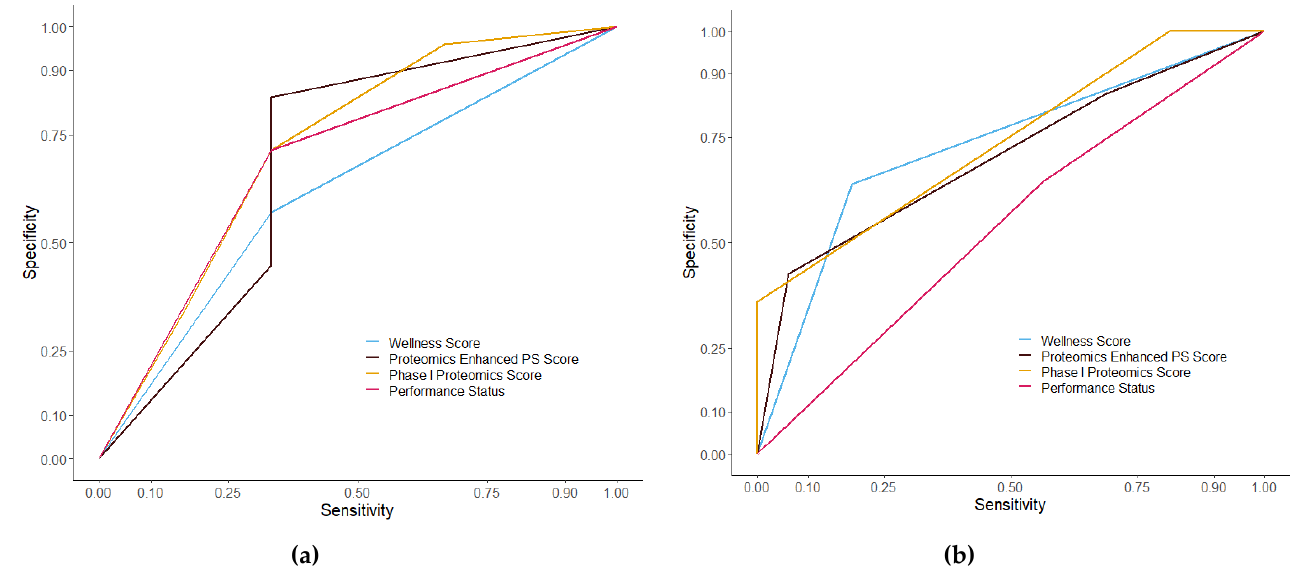
Figure 8. ROC curves comparing the different prognostic scores in the discovery cohort ( a ) and the validation cohort ( b ). The different scoring systems were analysed using receiver operating characteristics curves. In the discovery cohort ( a ) the AUC for PS score was 0.690 with a p value of 0.131, the AUC for PPM score was 0.832 with a p value of 0.008, the AUC for PEPS score was 0.810 with a p value of 0.014, and the AUC for Wellness Score was 0.755 with a p value of 0.043. In the validation cohort ( b ) the AUC for PS score was 0.549 with a p value of 0.548, the AUC for PPM score was 0.745 with a p value of 0.003, the AUC for PEPS score was 0.702 with a p value of 0.013, and the AUC for Wellness score was 0.726 with a p value of 0.006.